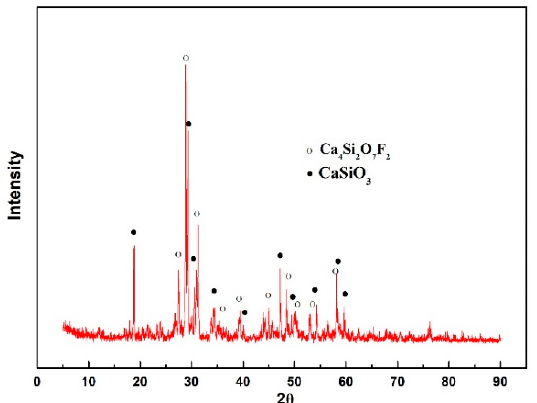
Figure 5. X-ray diffraction (XRD) patterns of the CaO–SiO 2 –CaF 2 -based mold flux at the cooling rate of 5 °C·min − 1 .